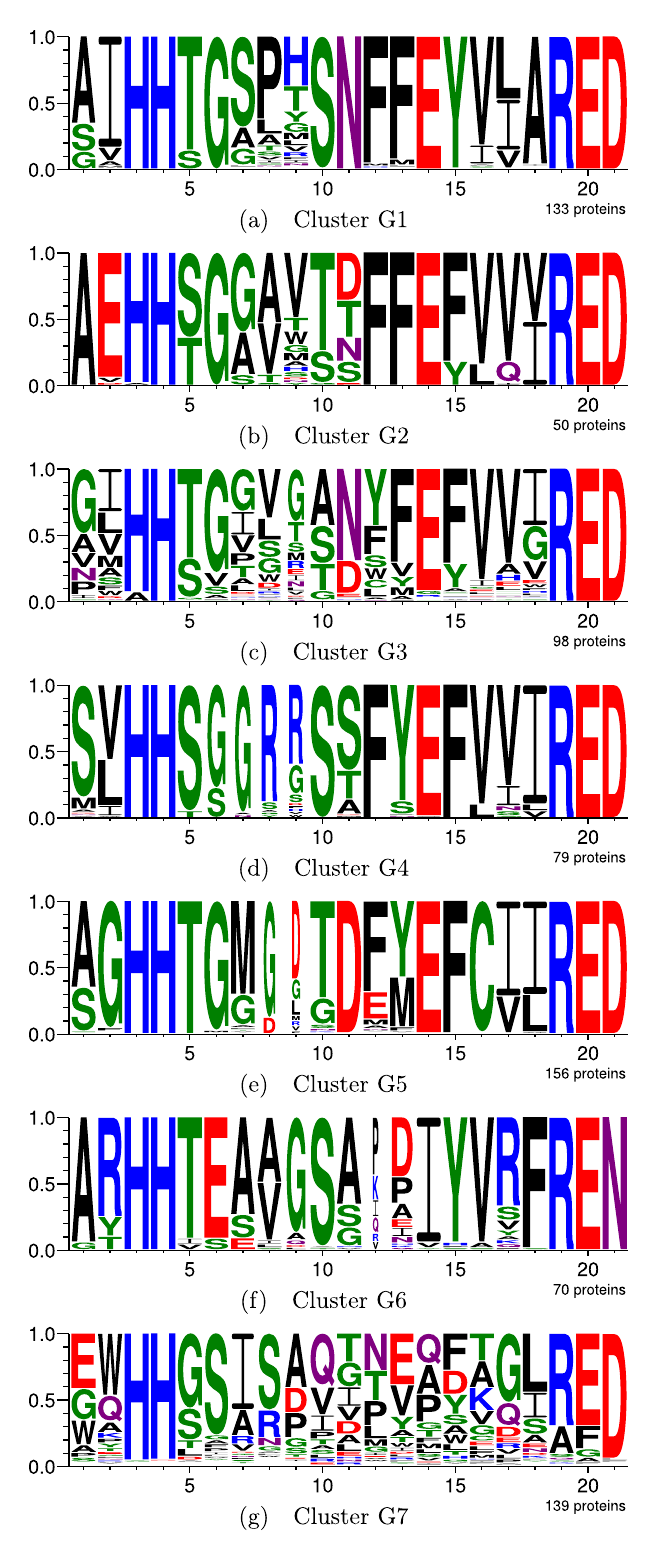
Fig 3. DUF849 division into seven clusters produced by manually altering ASMC ’ s hierarchical clustering in [1]. Subfigures (a) through (g) show the active site logos for clusters G1 through G7,